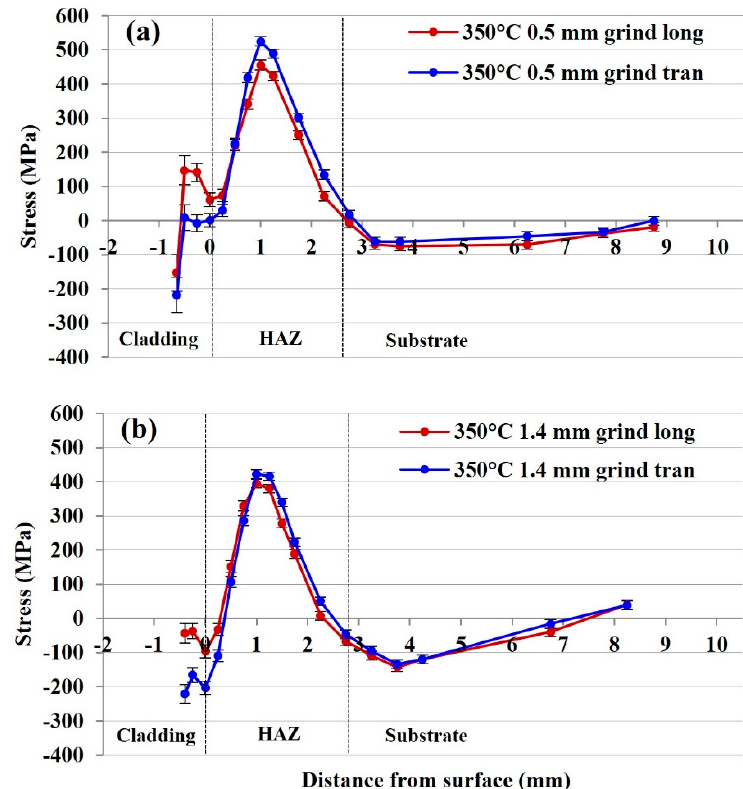
Figure 6. ( a ) Residual stress distribution of the 350 °C tempered, 415SS clad rail with 0.5 mm surface grinding and ( b ) residual stress distribution of the 350 °C tempered, 415SS clad rail with 1.4 mm surface grinding (long—longitudinal tran—transverse).